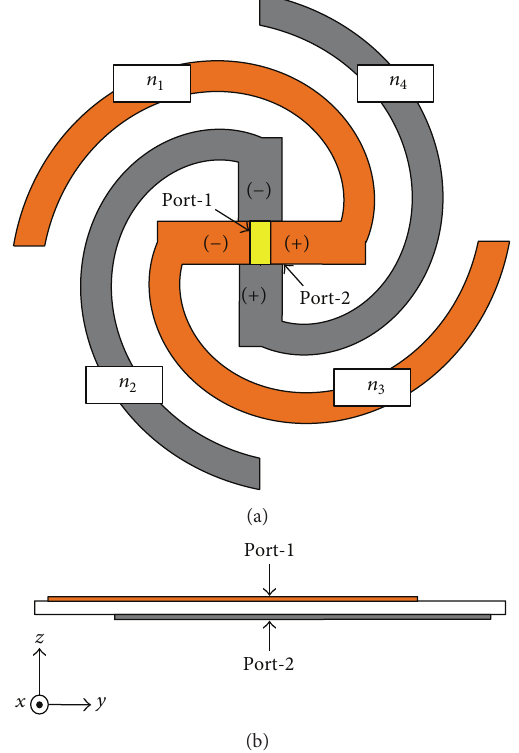
Figure 2: HFSS simulation modeling for an ideal four-arm curl antenna in free space: (a) top view and (b) side